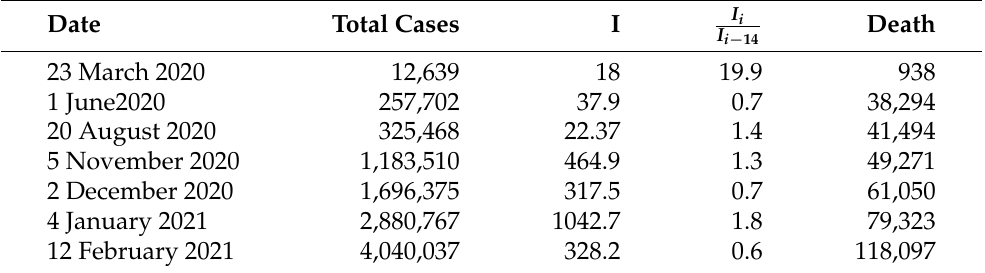
Table 5. Data for the UK: Total cases, Cases per 100,000 inhabitants in the last 14 days, rate of change of I in 14 days, Death related to COVID-19.